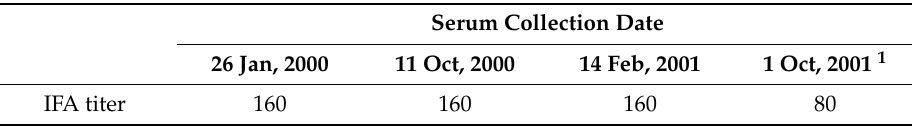
Table 3. EFV antibody titers determined by IFA tests in Horse A.